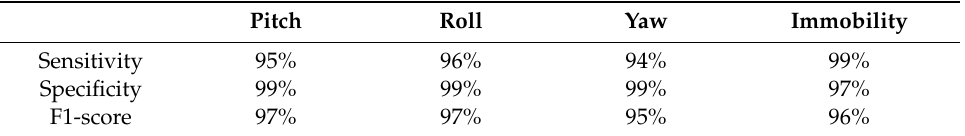
Table 6. Statistical measures showing detection results of head gestures for the SVM classifier with a 3rd degree polynomial and C = 1.0 (the classifier trained on raw IMU signals).